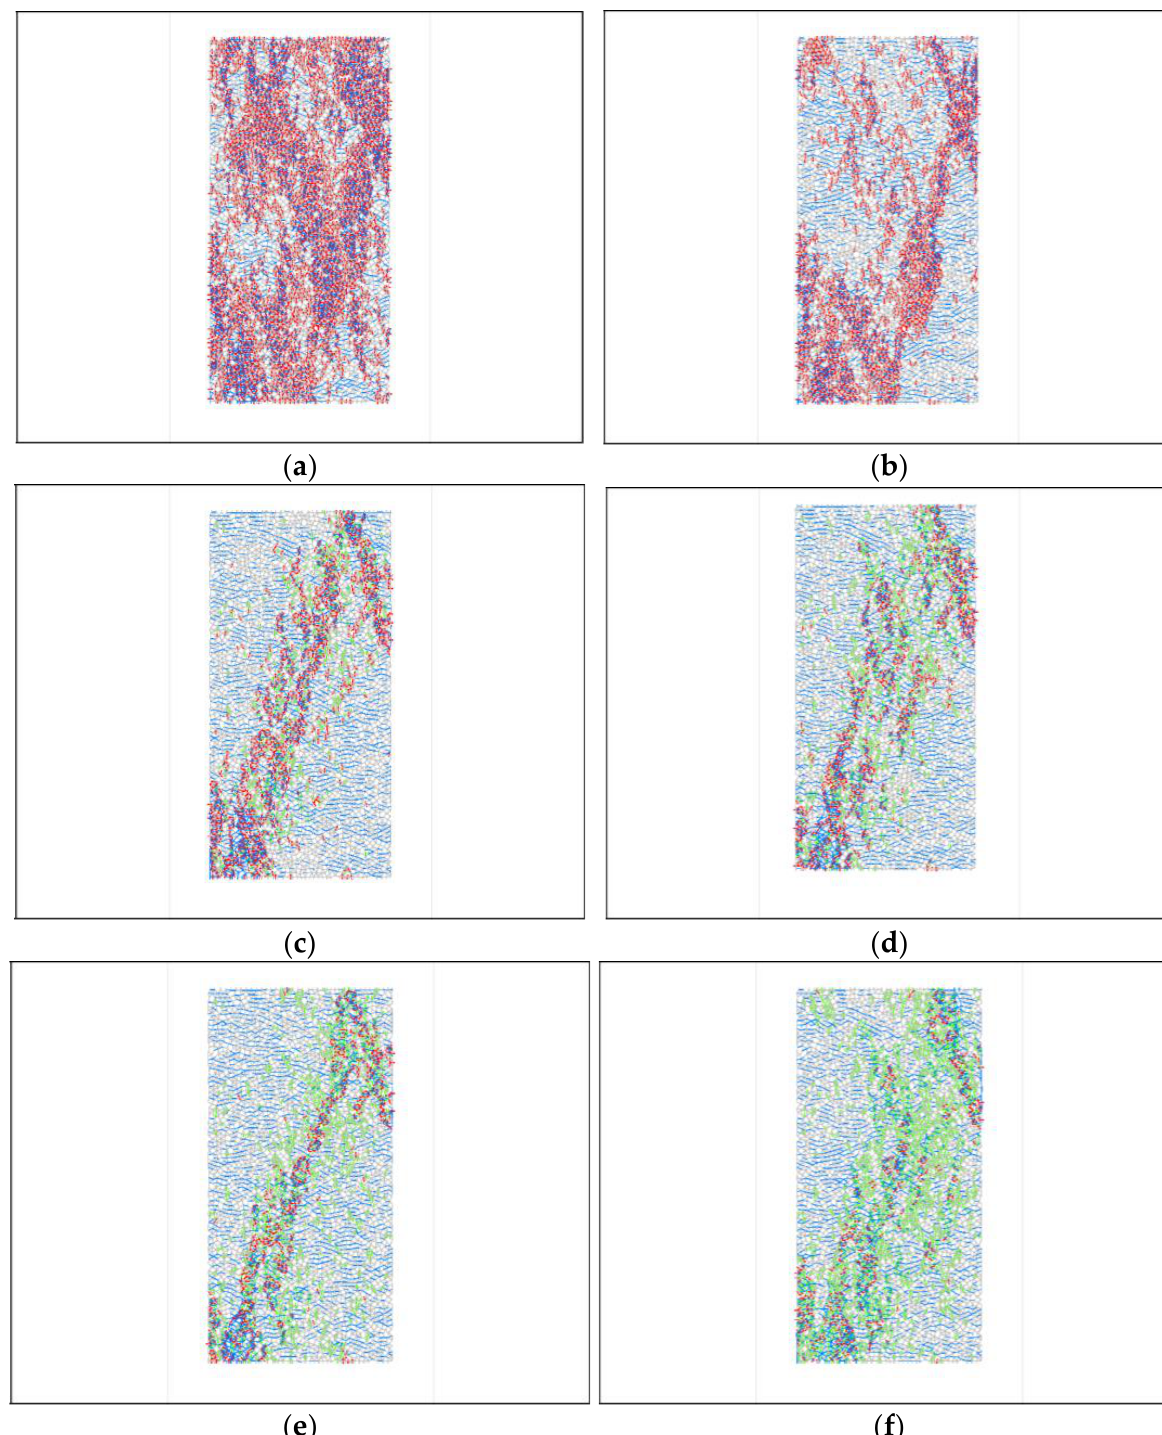
Figure 12. Parameter calibration of uniaxial compression bonding ratio, ( a ) ten_coh = 0.1, ( b ) ten_coh = 0.5, ( c ) ten_coh = 1.0, ( d ) ten_coh = 1.2, ( e ) ten_coh = 1.5, ( f ) ten_coh = 2.0. (As shown in the figure above, colored lines are cracks, and gray and white particles).